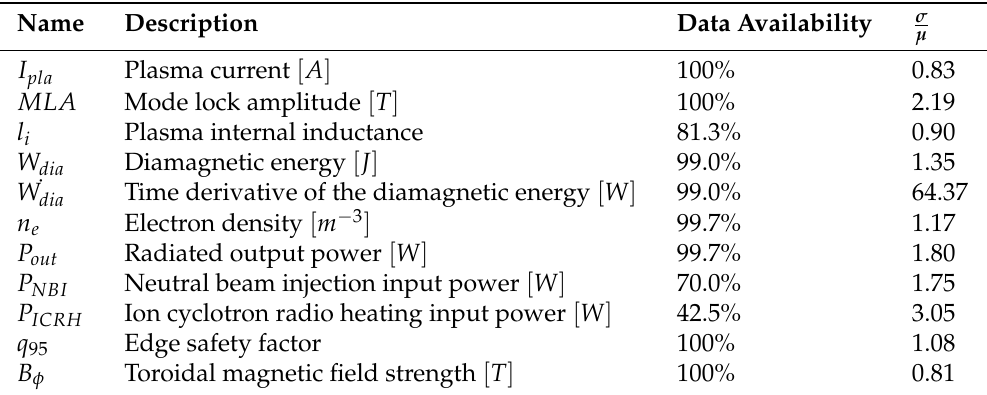
Table 1. List of the input features used to train the different predictor models. Selection based on Rattá et al. [24] and Rea et al. [13]. σ is the standard deviation and µ is the mean. The last column represents the relative standard